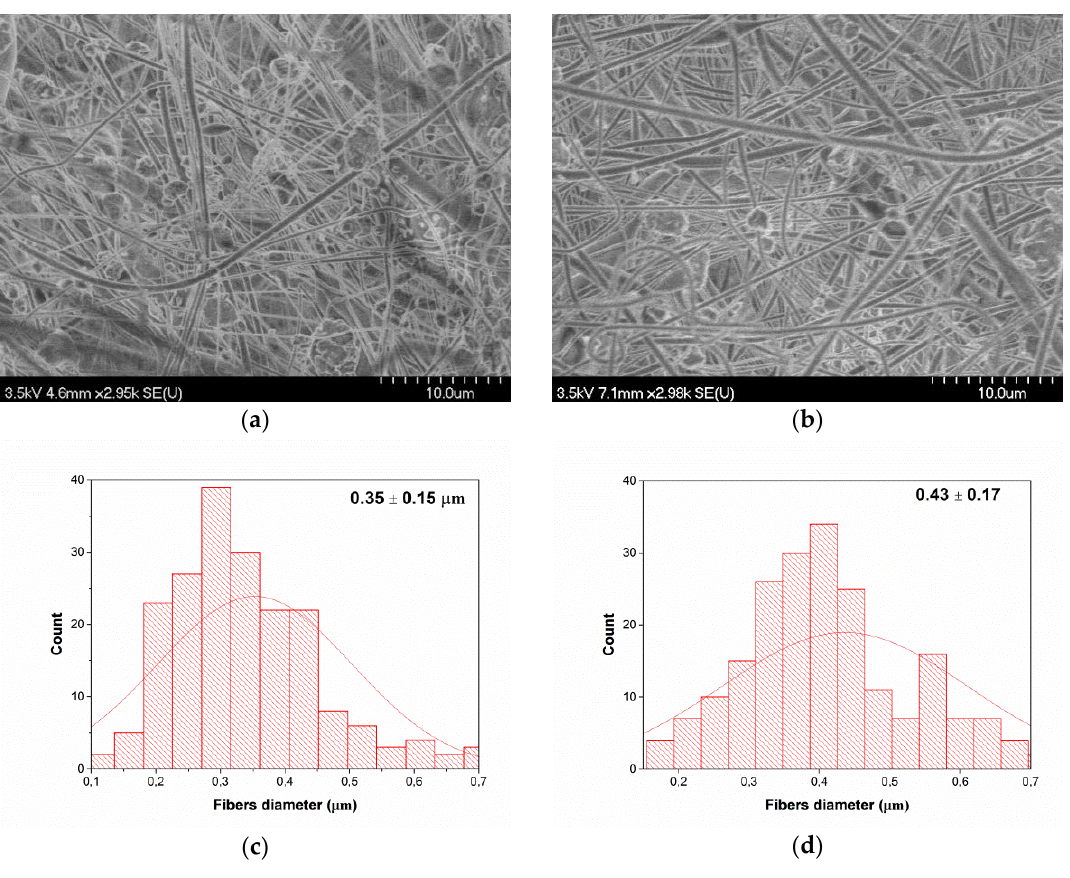
Figure 3. Morphology of electrospun PLA based mats: ( a ) PLA (10% w / v ), 1 wt % ZnO in TFE (0.5 mL/h, 35 KV, 15 cm), ( b ) PLA (10% w / v ), 1 wt % ZnO-UVM7 (Si/Zn = 5) in TFE (0.5 mL/h, 35 KV, 15 cm) and ( c ) and ( d ) are fiber diameter distribution of ( a ) and ( b ), respectively. The scale bars represent 10 µm.